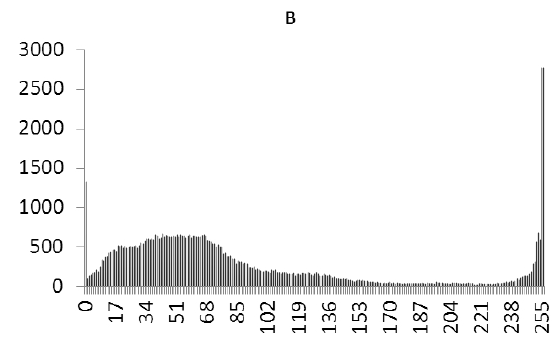
Figure 28. Statistical chart of B value distribution of the original